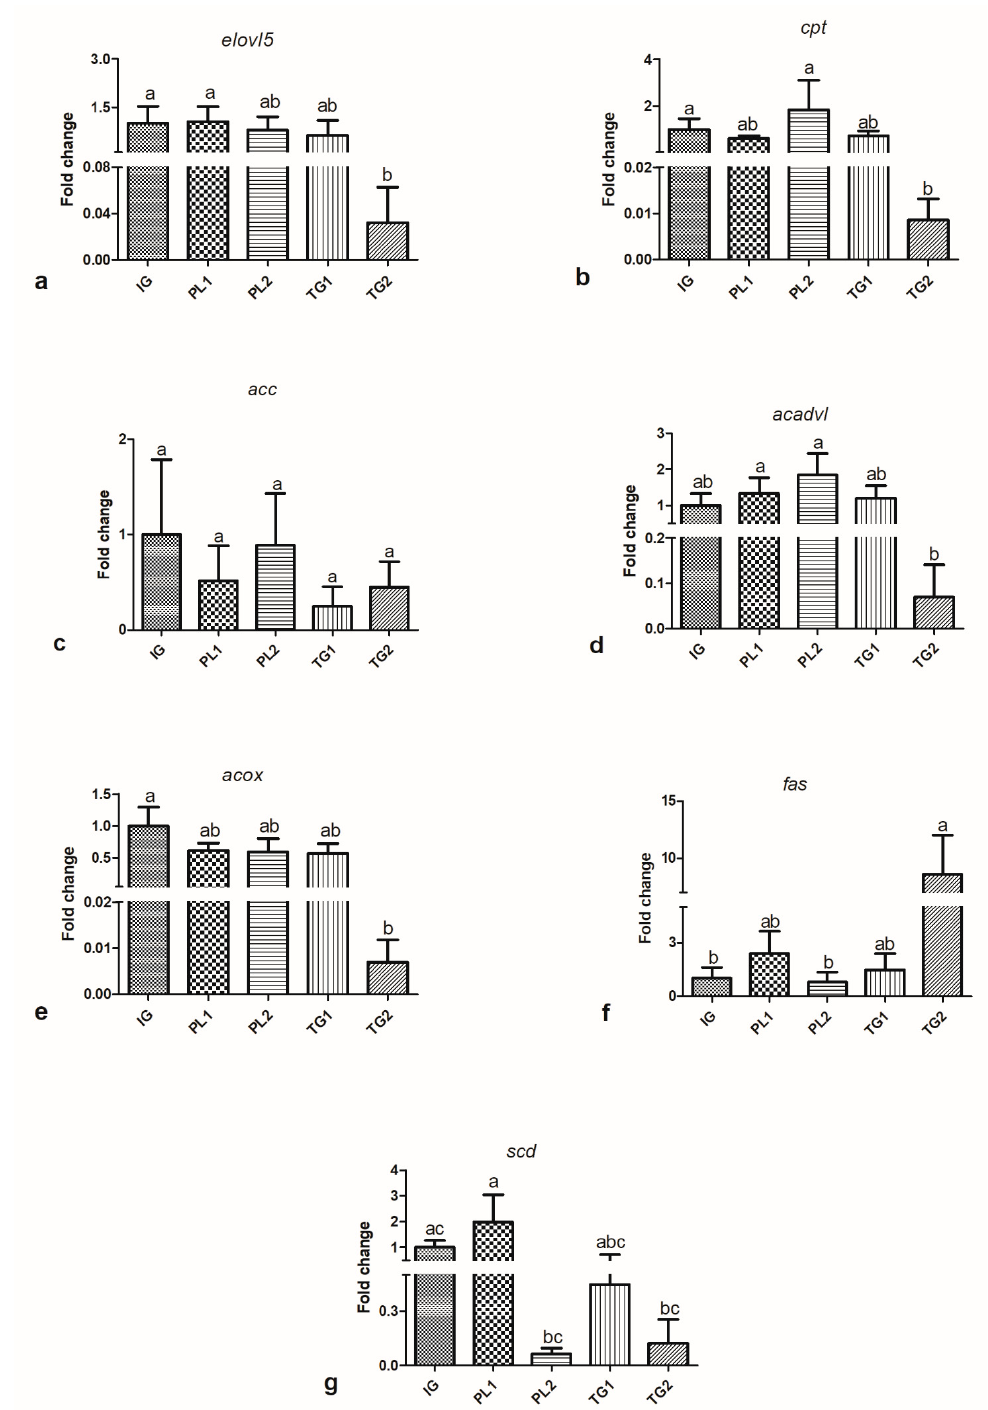
Figure 1. Relative expression levels of FA synthesis and β -oxidation genes ( a ) evovl ; ( b ) cpt , ( c ) acc , ( d ) acadvl ( e ) acox ( f ) fas ( g ) scd . The values represent the mean ± standard errors ( n = 6). The transcript level from each gene is calculated relative to the other genes’ levels using the raw cycle threshold value for each gene and then normalized against ef1a . The values shown are the fold induction changes relative to the average Ct value for all genes. PL1-low levels of phospholipids; PL2-high level of phospholipids; TG1-low levels of triglycerides; TG2-high levels of triglycerides. The different letters present significant ( p < 0.05) differences among